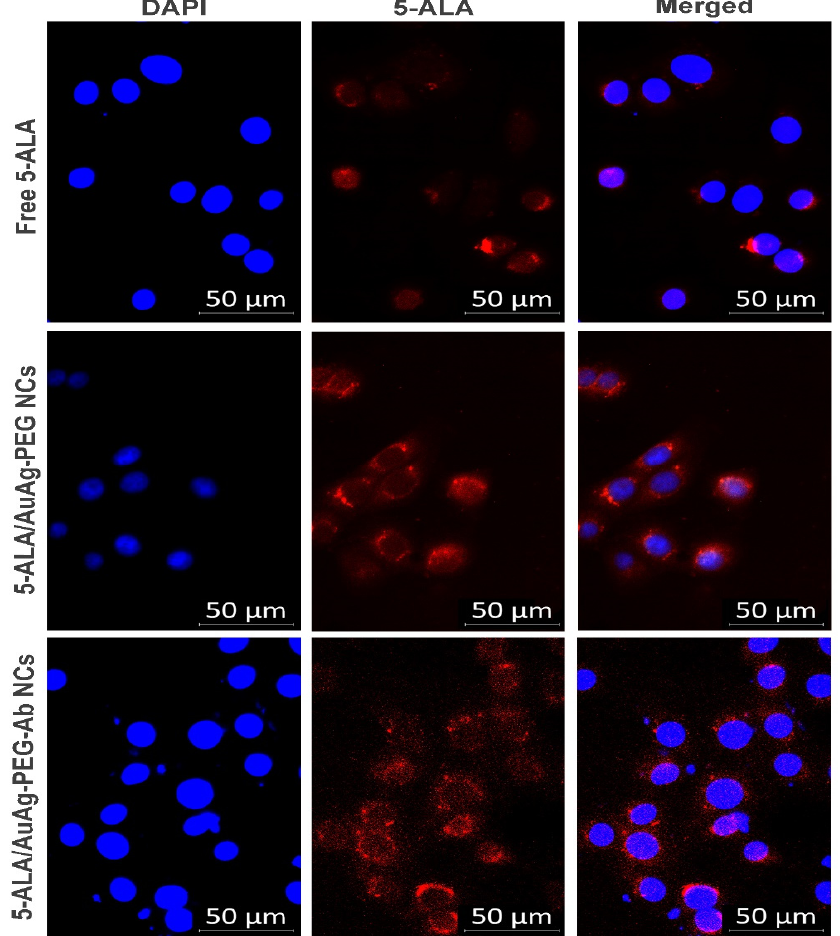
Figure 2. Subcellular localization of free 5-ALA, 5-ALA/Au–Ag-PEG, and 5-ALA/Au–Ag-PEG-Ab NCs under an equivalent concentration of 5-ALA after 20 h of incubation. The images in each row show DAPI-stained nuclei (blue), PpIX fluorescence (red), and their overlays, respectively.